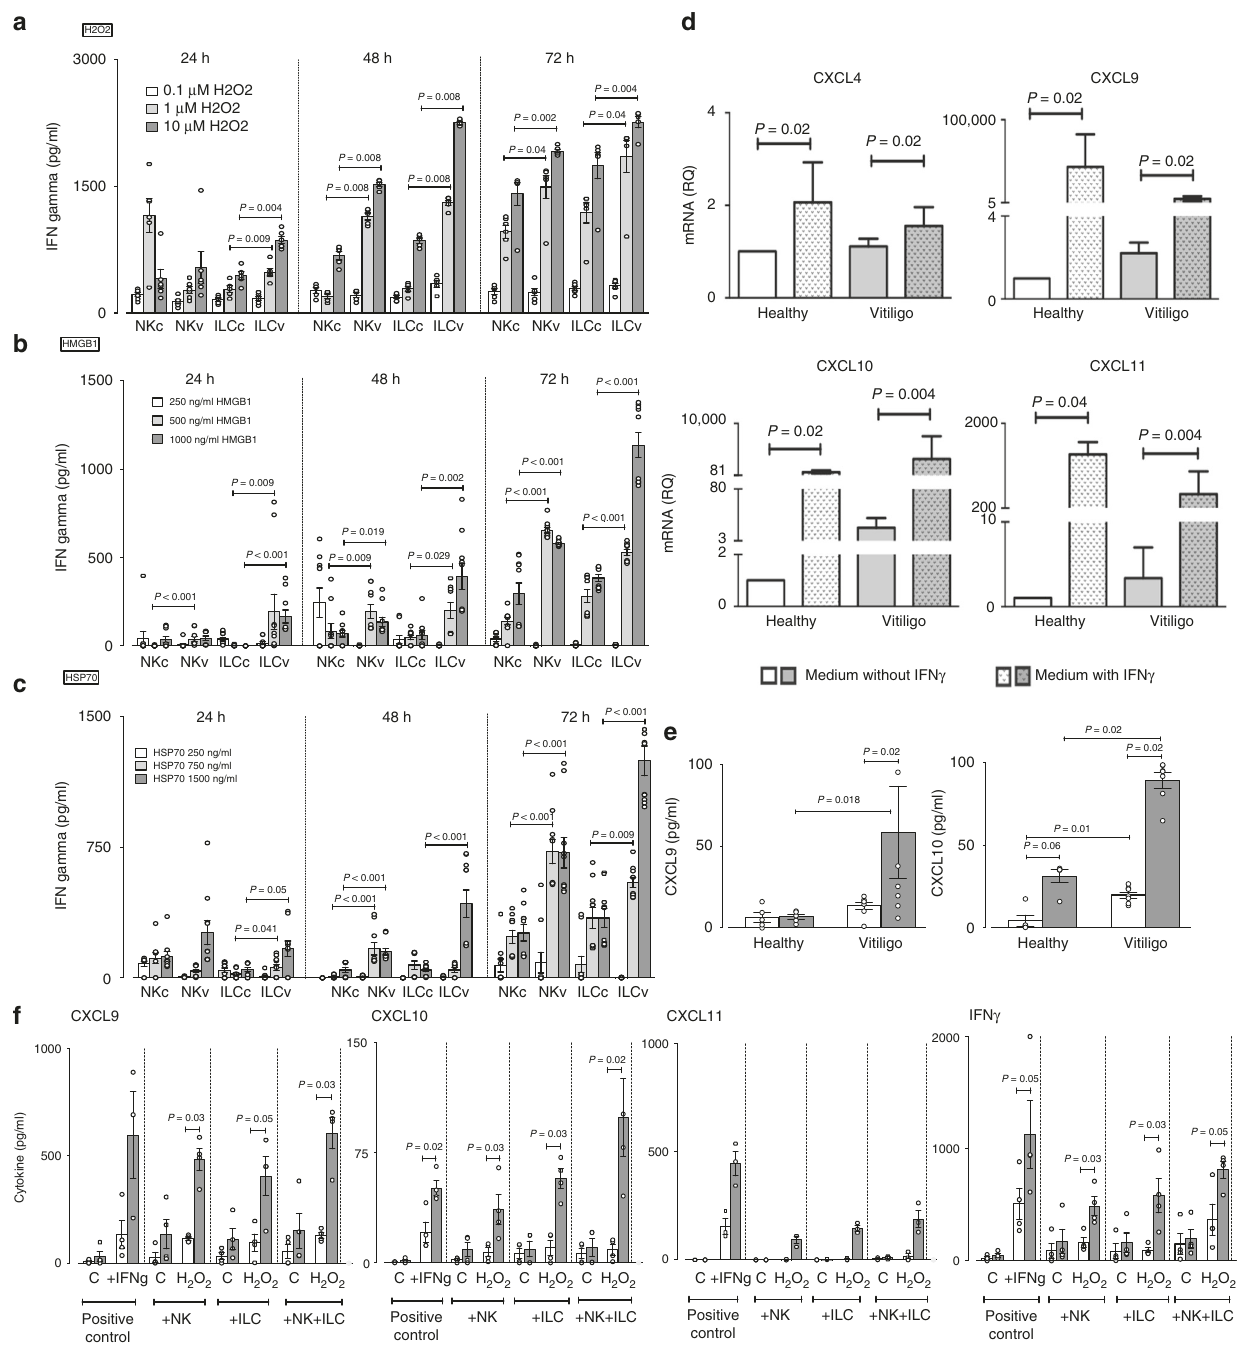
Fig. 2 Effect of stressed innate immune cells on melanocyte function. IFN γ production by sorted NK and ILCs from blood of healthy control (c, n = 6 – 10) and vitiligo (v, n = 6 – 10) subjects following in vitro stimulation with H 2 O 2 (0.1 – 10 μ M) ( a ), HMGB1 (250 – 1000ng/ml) ( b ) or HSP70 (TKD, 250 – 1500ng/ml) ( c ) for 24, 48 or 72 h. The effect of exogenous IFN γ (50ng/ml) on CXCL4, CXCL9, CXCL10, CXCL11 mRNA ( d ) and CXCL9, CXCL10 protein ( e ) production by healthy ( n = 4 – 7) and vitiligo melanocytes ( n = 7 – 9). In f chemokine and IFN γ production was measured 24h post stimulation of healthy (white bars, n = 4) or vitiligo (grey bars, n = 4) melanocytes with patient ’ s own autologous NK or ILCs (alone or in combination) which were pre-stressed with H 2 O 2 for 48h before addition of innate cells to patients own melanocytes. Positive control condition represents melanocytes directly pre-stimulated with IFN γ (50ng/ml) for the same duration of time. PCR results are normalized to house-keeping gene SB and expressed as fold change in expression relative to the pool of healthy skin samples. Results are shown as individual dot plots with a line either at median ( a – c ) or at mean ±SEM ( e , f ) same dose (Fig. 2a) suggesting vitiligo innate cells were more with H 2 O 2 (to induce oxidative stress in cells). Results have shown sensitive to oxidative stress compared to cells from healthy con- H 2 O 2 to induce IFN γ production in both NK and ILCs and this effect was dose- and time-dependent (Fig. 2a). The stress-induced trols. Innate cells can be activated by many DAMPs. Among them, IFN γ production by NK and ILCs from vitiligo subjects were the role of HSP70 Heat Shock Protein (HSP70) and High Mobility signi fi cantly higher compared to healthy subject ’ s responses at the Group Box (HMGB)1 in vitiligo pathogenesis have been suggested NATURE COMMUNICATIONS| (2019) 10:2178